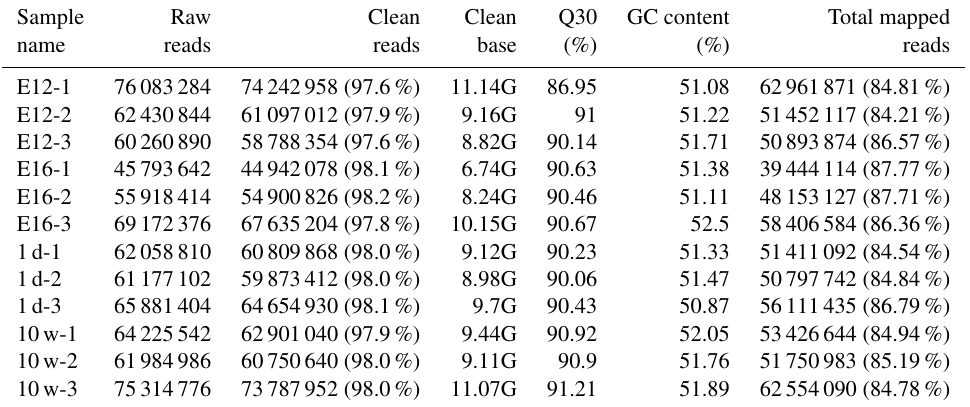
Table 1. Data summary from RNA-Seq. Sample Raw Clean Clean Q30 GC content Total mapped